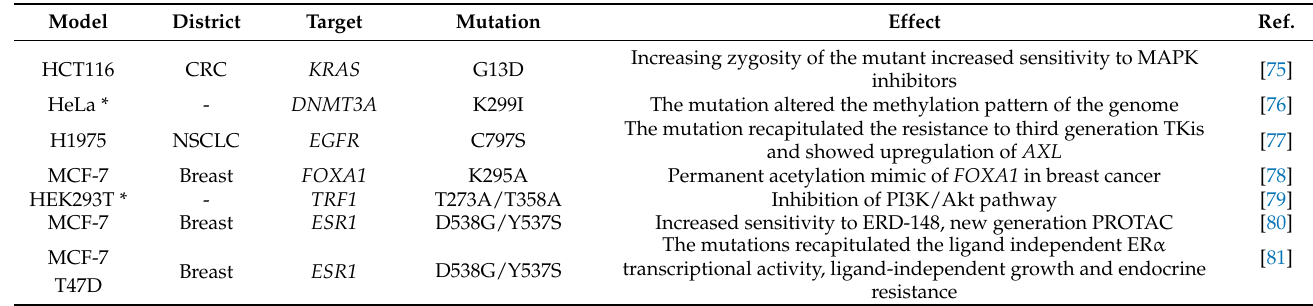
Table 2. List of mutations knocked into different in vitro